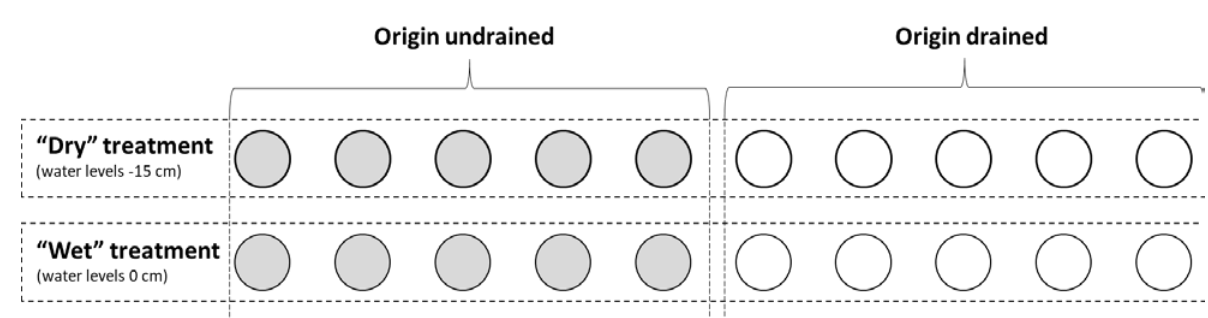
Figure A1. Experimental set-up. A total of 20 monoliths was collected in one originally undrained site (10 monoliths) and one long-term drained site (10 monoliths). The monoliths were then subjected to a permanent (re-)wetting “wet” or partial drying “Dry” treatment in a balanced design (random allocation of monoliths), with 5 replicate monoliths per treatment combination.